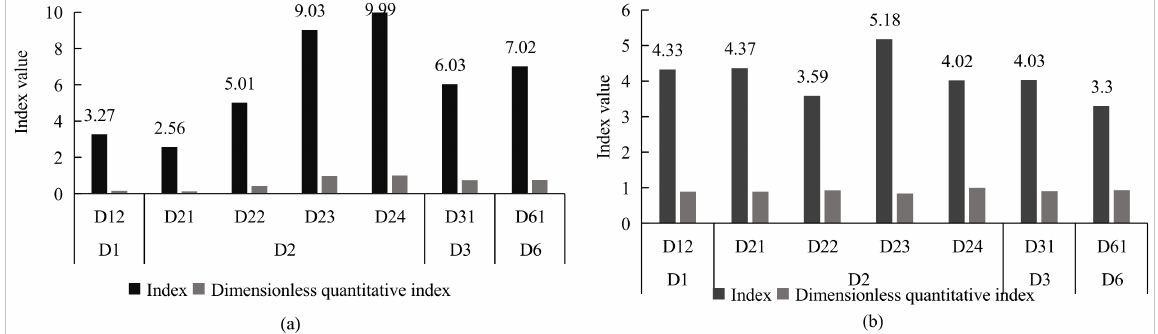
Figure 5. The results of dimensionless quantitative index of sum. ( a ) Dimensi onless quantitative index (0–10); ( b ) Dimensi onless quantitative index